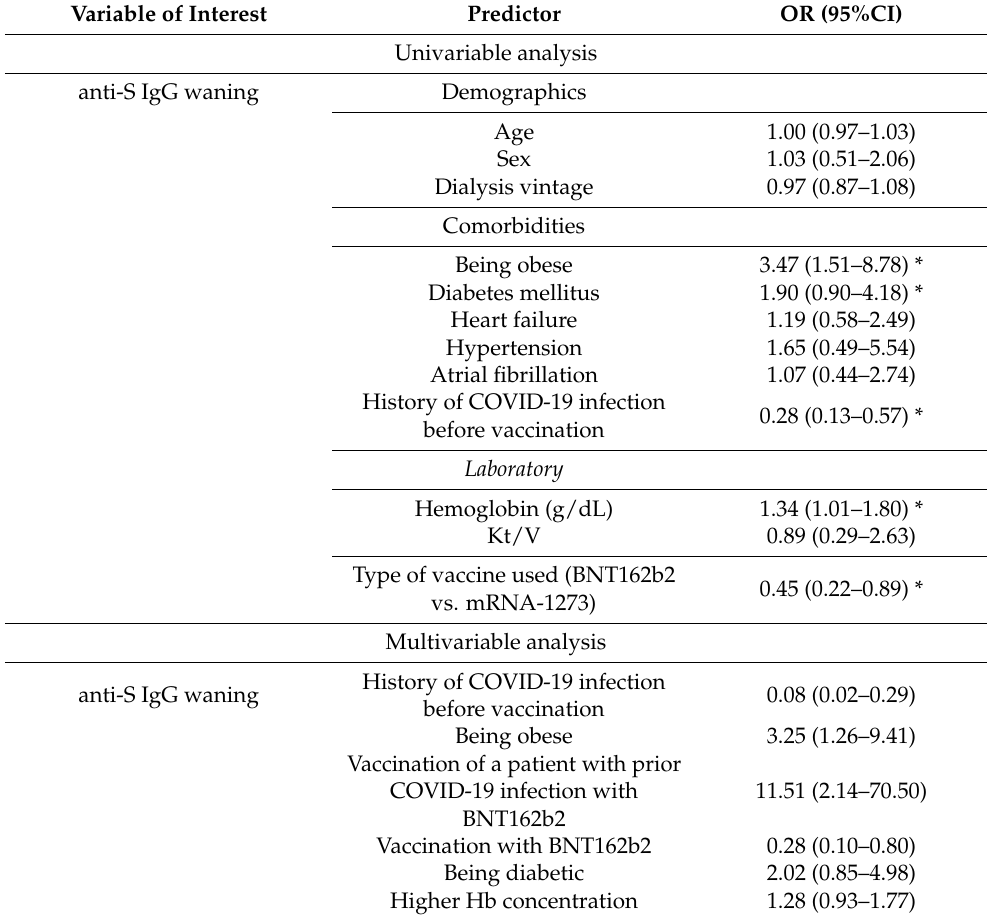
Table 3. Predictors of anti-S IgG waning. Results of a univariable and multivariable logistic regression (OR odds ratio, CI confidence interval).